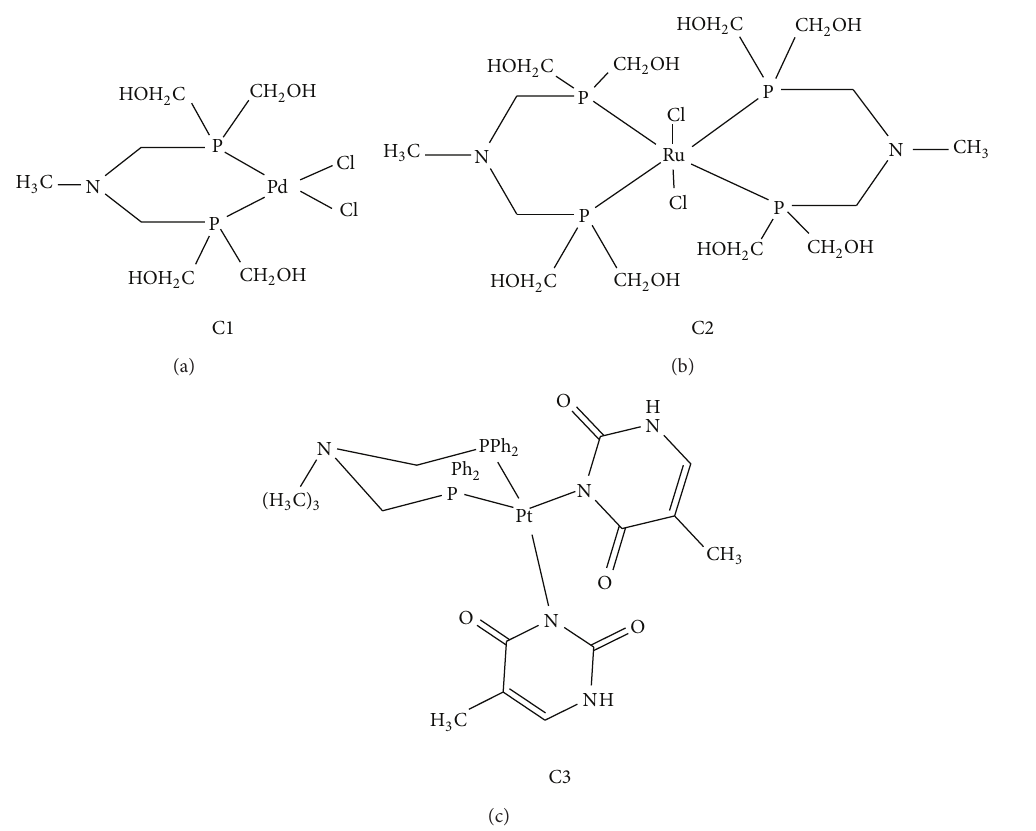
Figure 1: Molecular structures of the phosphine metal complexes